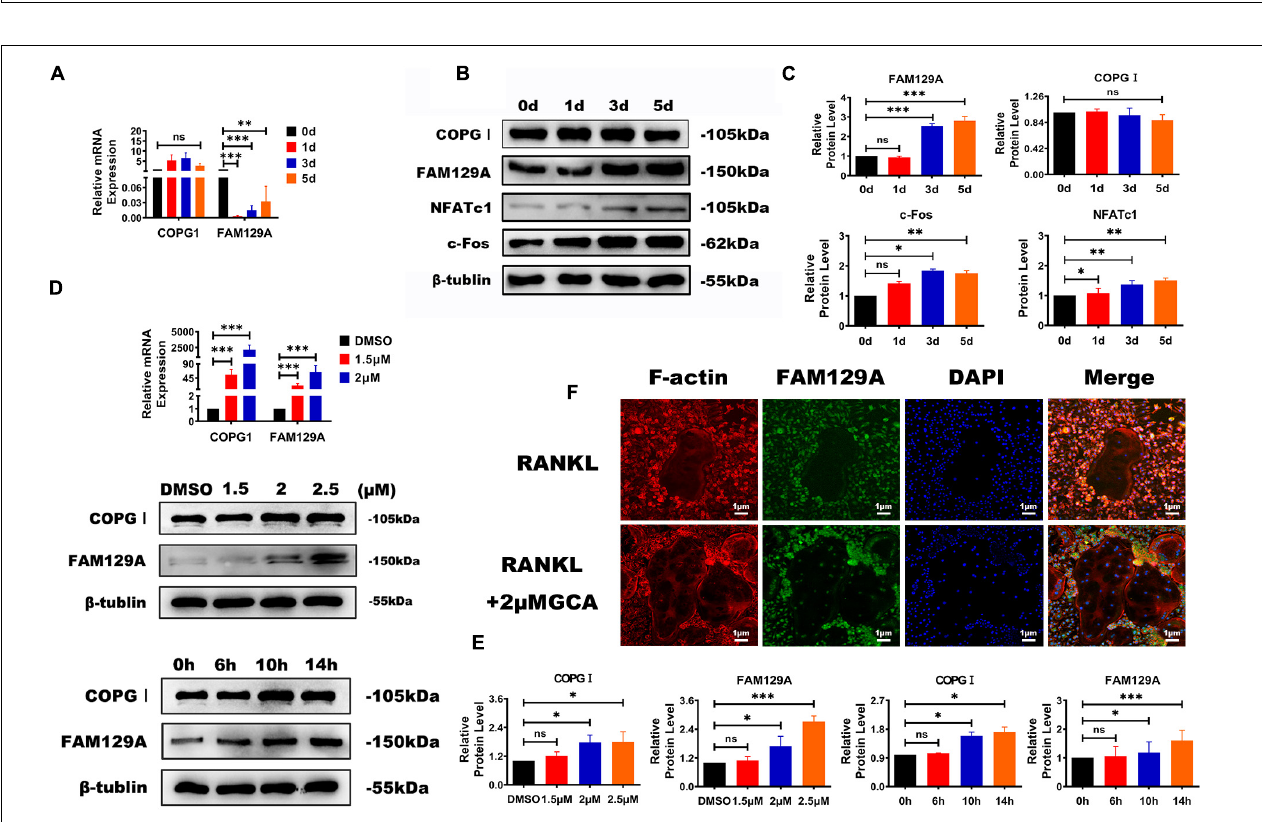
FIGURE 3 | Functional effects of GBF1 on COPGI and FAM129A. (A–C) The mRNA expression and protein levels of c-Fos, NFATc1, COPGI, and FAM129A at different stages of osteoclast differentiation were examined by quantitative real-time PCR and Western blot, respectively. The intensity of the blots was quantified using densitometry scan and Image J software. The undifferentiated group (Day 0) was used as the control group. (D,E) Cultured RAW264.7 cells in the presence of RANKL (50 ng/ml) were treated with 2 µ M of GCA for 0, 6, 10, and 14 h and at 1.5, 2, and 2.5 µ M concentration of GCA for 3 days. Quantitative real-time PCR and Western blot were used to analyze the expression of COPGI and FAM129A. (F) Osteoclasts derived from RAW264.7 cells were incubated with 2 µ M of GCA for 1–2 days, and the actin rings, FAM129A, and nuclei of osteoclasts were stained with phalloidin-FITC, FAM129A antibody, and DAPI, respectively (original magnification, × 20). Data are expressed as mean ± SD of three independent experiments. ∗ p < 0.05; ∗∗ p < 0.01; ∗∗∗ p < 0.001.